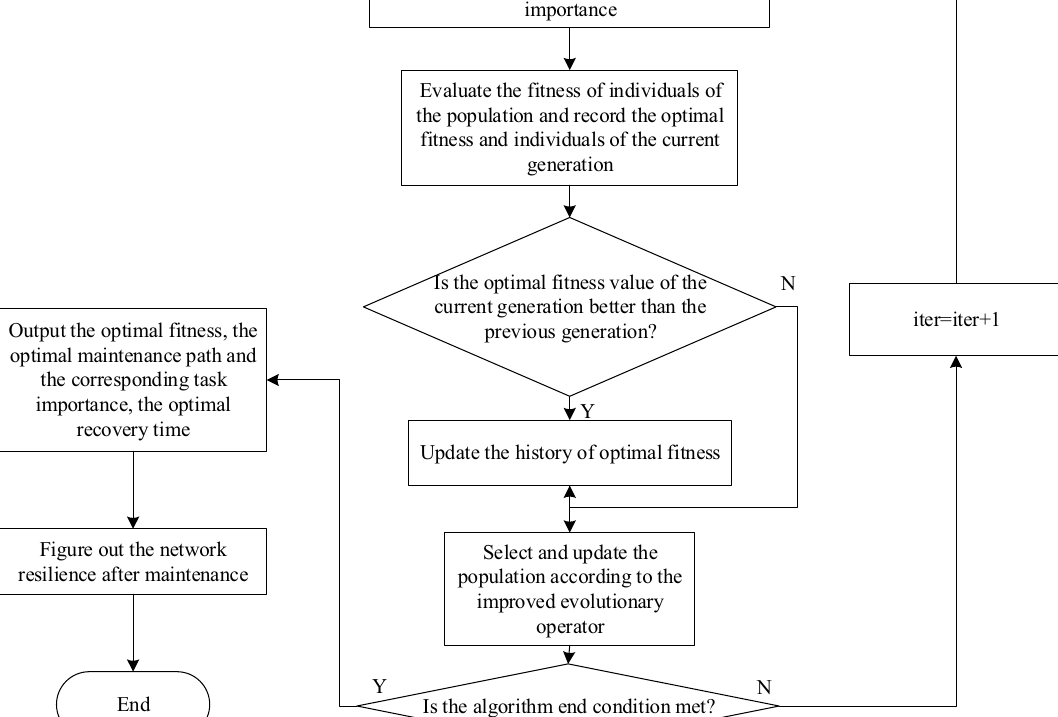
is got. The flowchart of algorithm implementation is shown in Fig. 4.